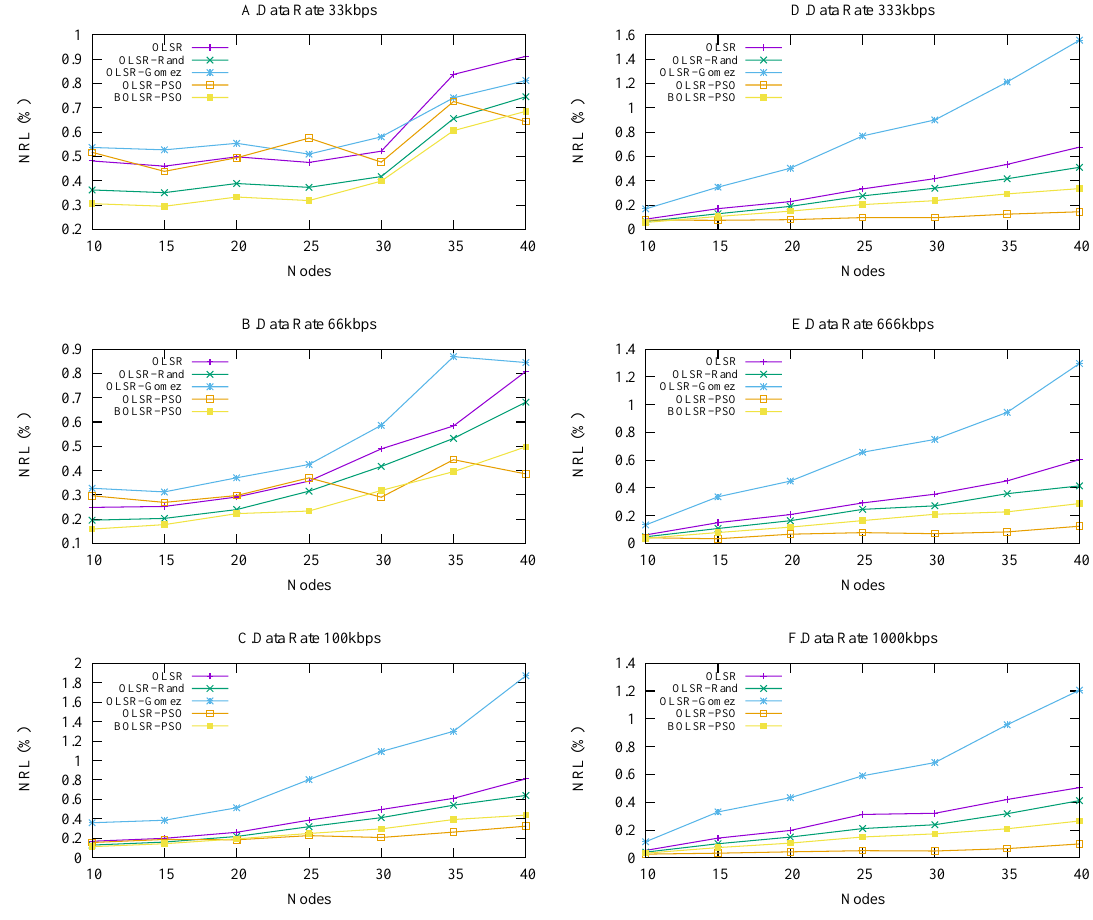
Figure 8. Normalized Routing Load vs. Number of Nodes.